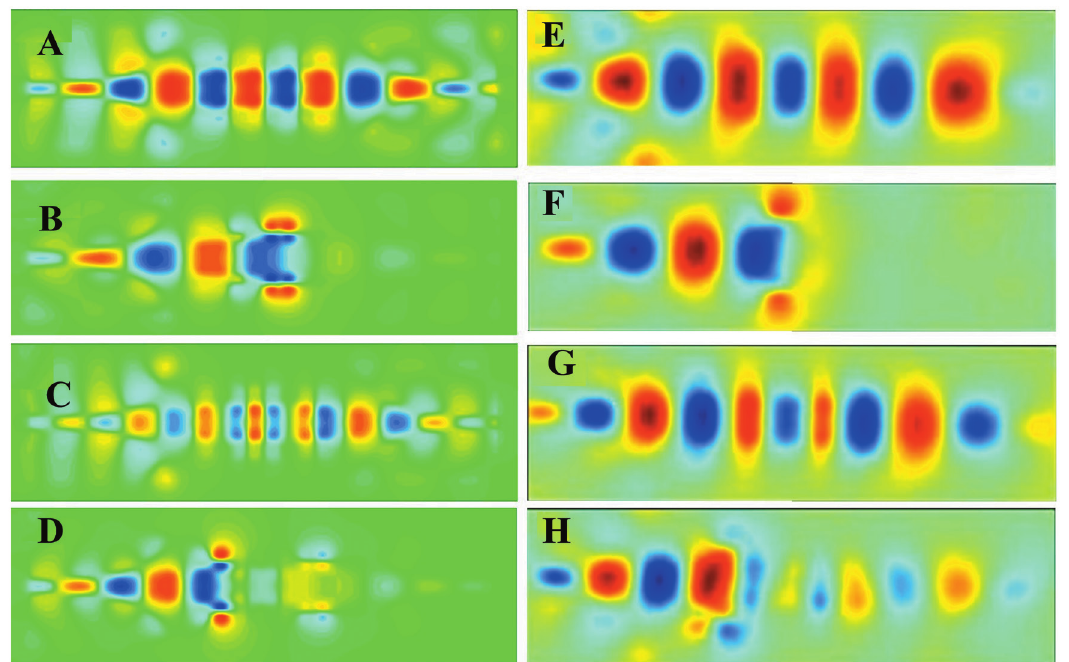
Figure 17: The near electric field distributions of the double-frequency rejection SPP waveguide at different frequencies. (A–D) The simu- lated results at 7.9 GHz, 7.65 GHz, 9.1 GHz, and 9.47 GHz. (E–H) The measured results at 7.9 GHz, 7.65 GHz, 9.1 GHz, and 9.47 GHz. Repro- duced from [44] with permission.